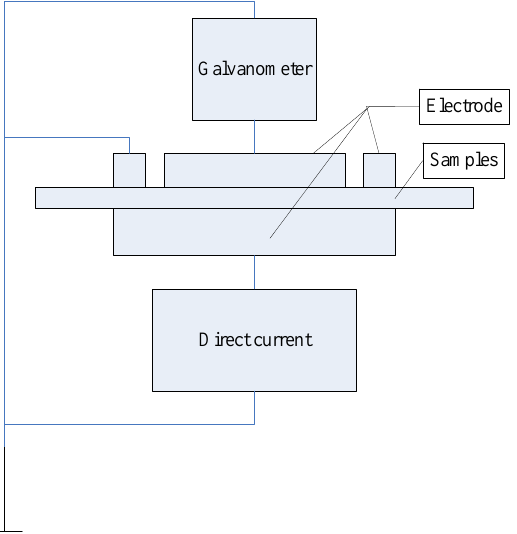
Figure 4. Conductivity characteristics testing device.